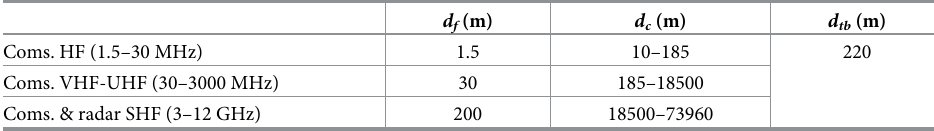
Table 2. Minimum flight distance according to criteria.